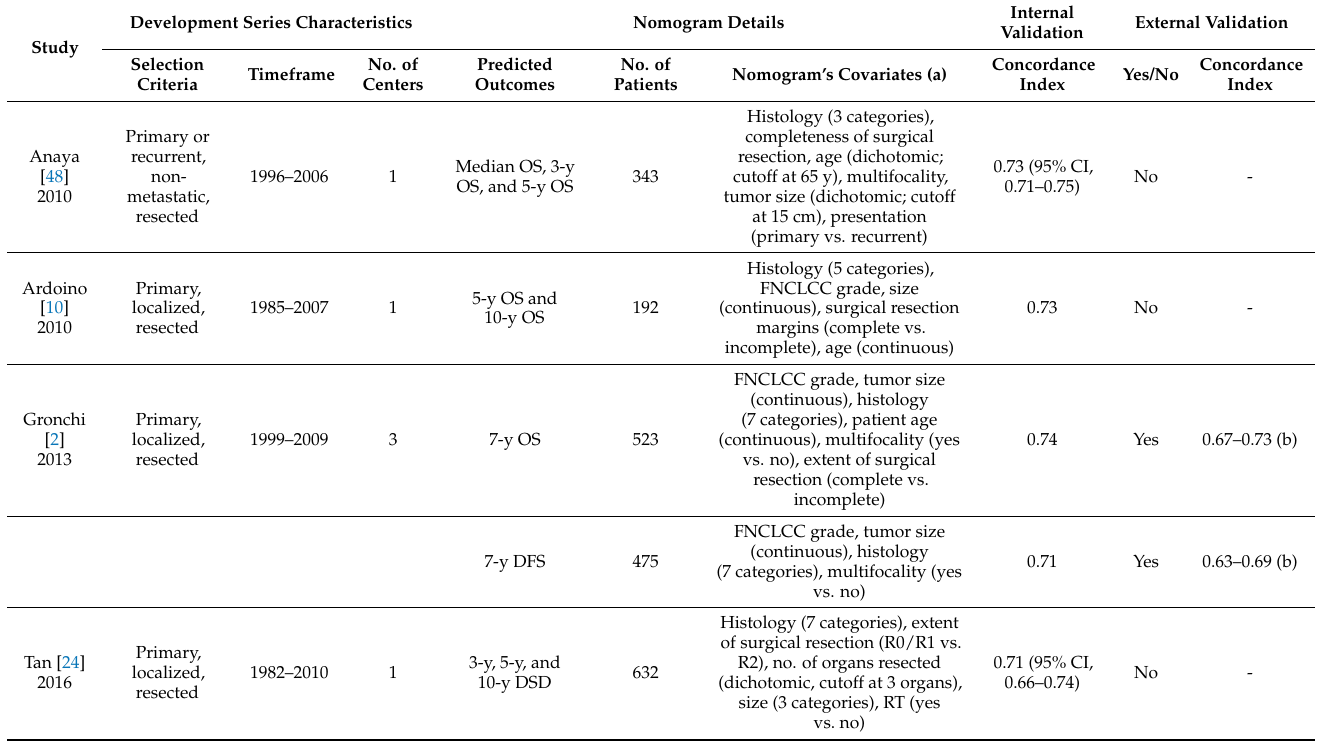
Table 2. Nomograms for Patients With